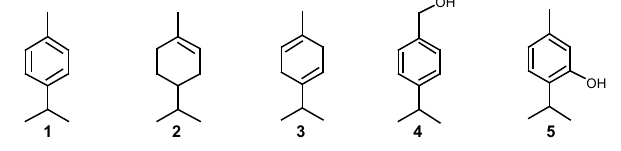
Figure 1: Chemical structures of the compounds identified in a relative amount ≥5%, in the essential oils isolated from the leaves and flowers of Ammoides pusilla . ( 1 ) p -cymene, ( 2 ) limonene, ( 3 ) γ-terpinene, ( 4 ) cumin alcohol and ( 5 )